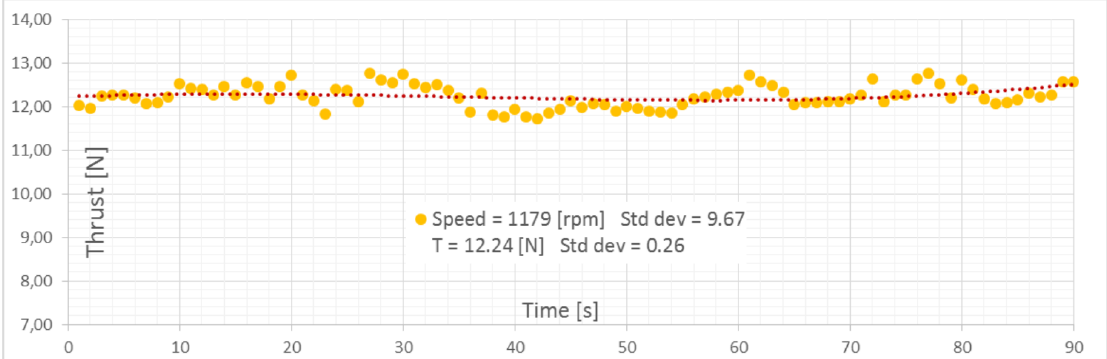
Figure 20. Results of bollard pull thrust tests at design RPM.